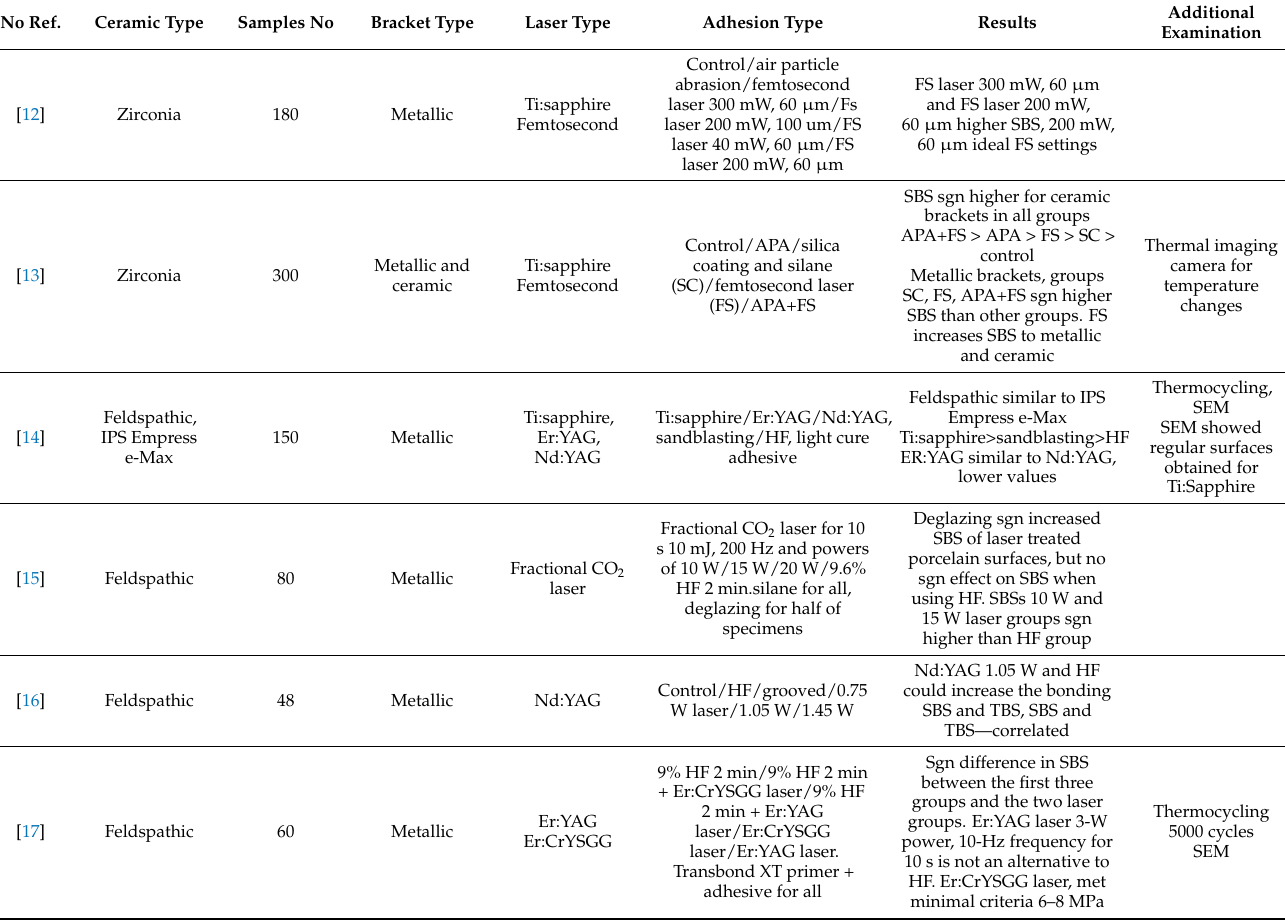
Table 2. Articles of laser usage for bonding to ceramic